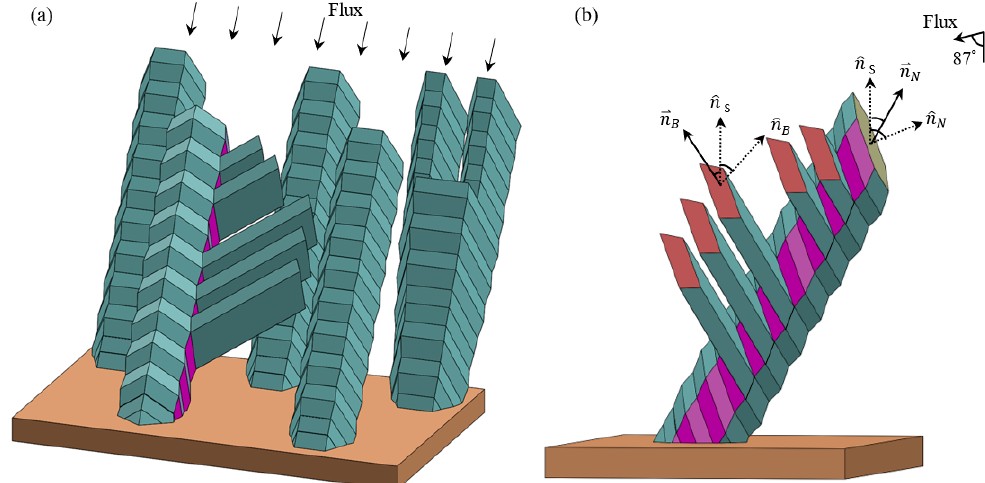
(cid:42) (cid:42) n B , n N are the axial